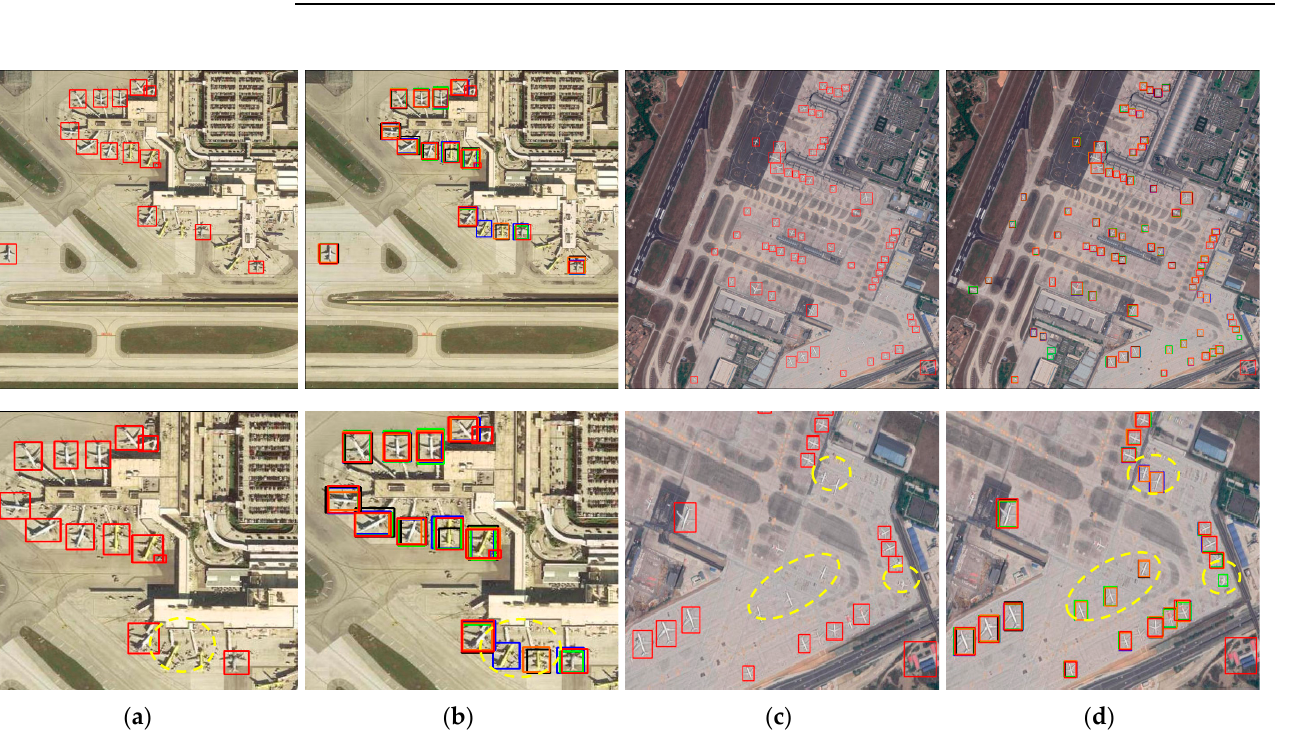
Table 8. Performance of models with different module on Dataset II.